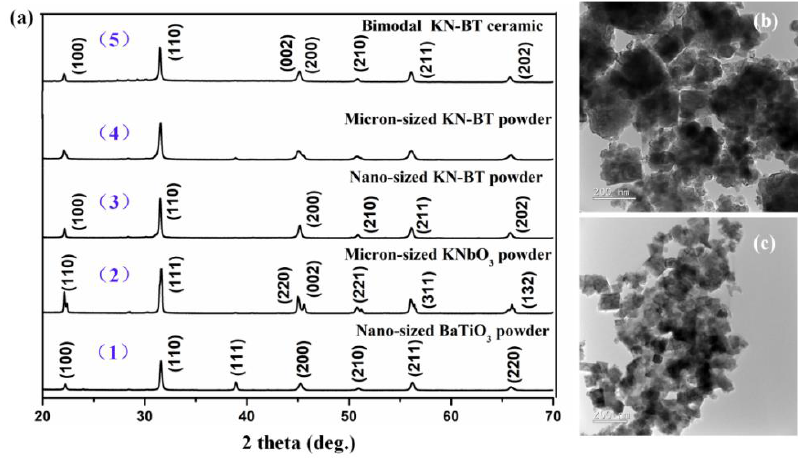
Figure 2. ( a ) XRD patterns of the (1‒4) powders: (1) the commercial nano -sized BaTiO 3 , (2) micron- sized KNbO 3 , (3) nano-sized KN-BT(9/1) matrix powders, and (4) micron-sized KN-BT(9/1)